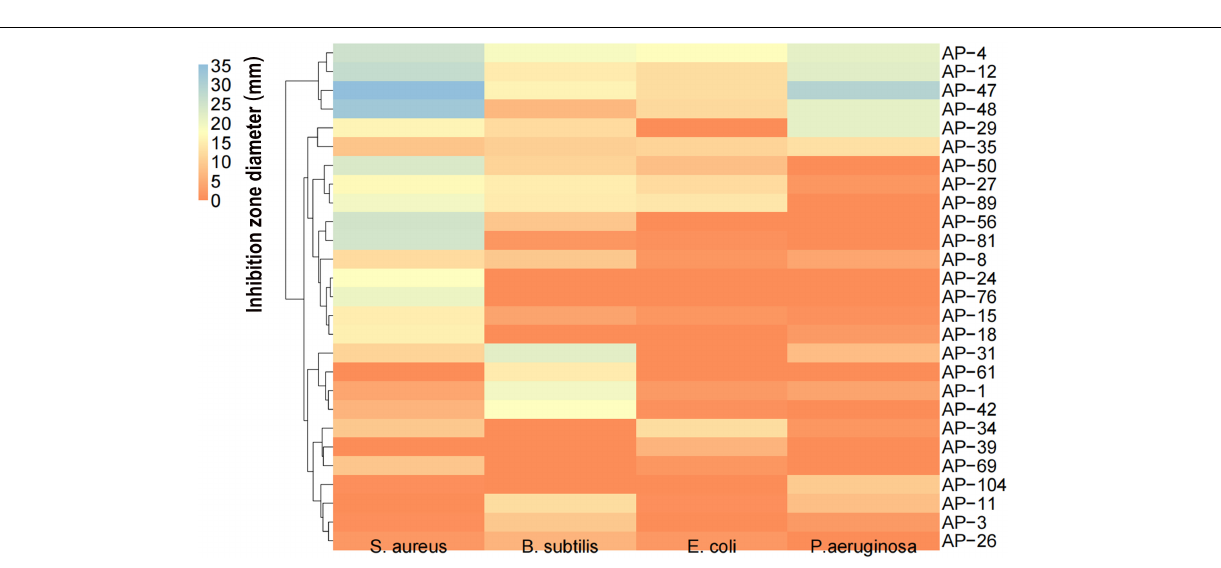
Among them, the EXE total phenol content of AP-1 and AP-4 is 110.194 ± 11.800 and 101.576 ± 9.073 µ g GAE/ml, and the total flavonoid content is 87.217 ± 8.854 and 77.101 ± 3.510 µ g RE/ml, respectively, both of which are significantly higher compared with other strains ( p <